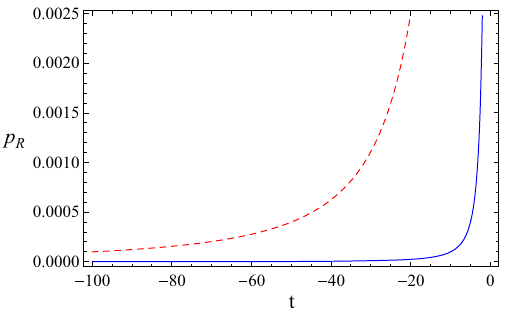
Fig. 2 Radial pressure as a function of time at the center (dashed line) and surface (solid line) of the